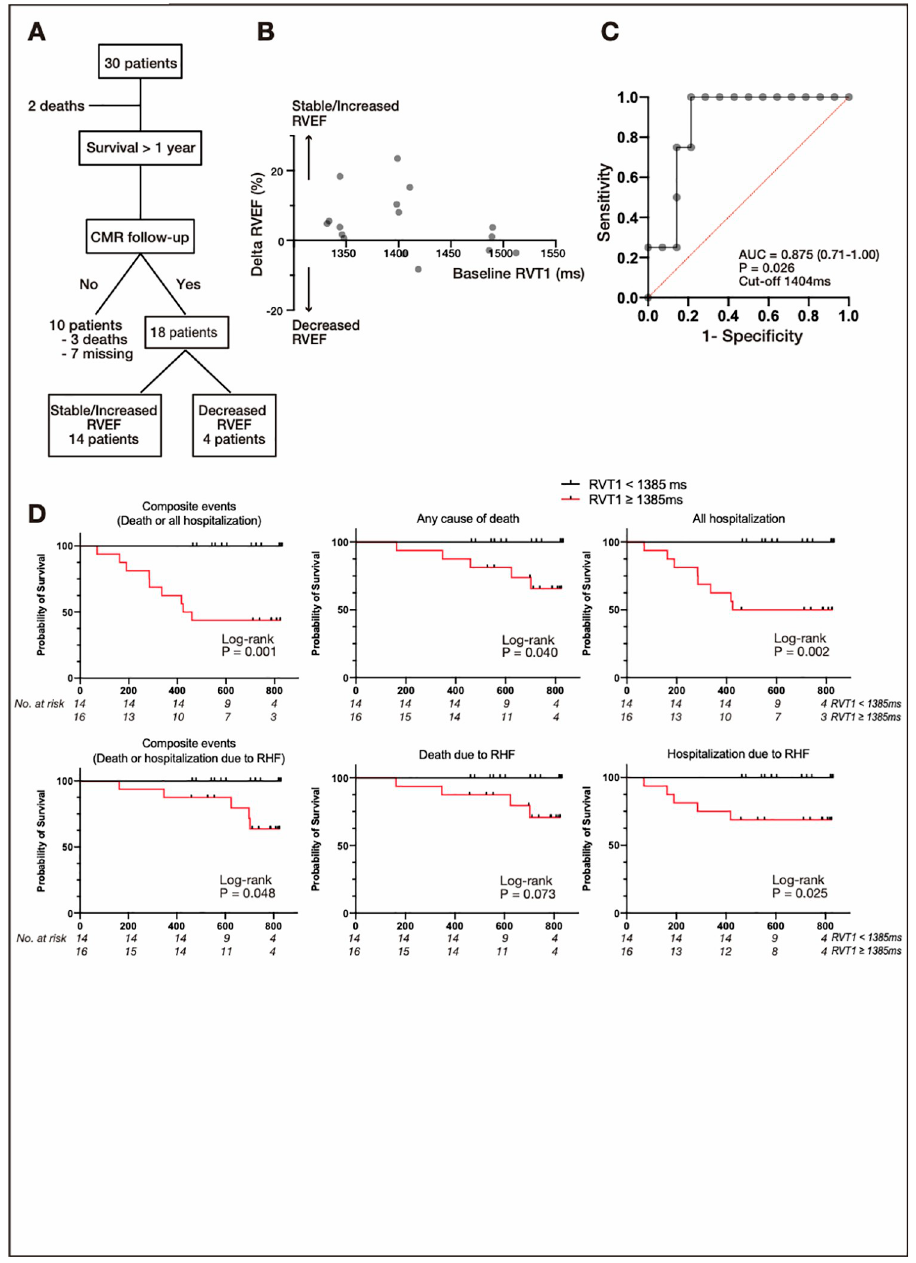
Fig 2. Predictive value of RVT1 for the decreased RV ejection fraction (RVEF) and poor outcome in pulmonary arterial hypertension (PAH). (a) Study profile. Thirty patients were enrolled (evaluating outcomes), and native T1 mapping using CMR and RHC was performed. Eighteen patients underwent volumetric CMR over a 12-month follow-up period (evaluating changes in RVEF). (b) Relationships between changes in the RVEF and baseline RVT1. (c) The receiver characteristics curve analysis for a decreased RVEF at follow-up. We defined a change of +3% or − 3% (between baseline and follow-up over 12 months) as an increased or decreased RVEF, respectively. (d) Survival curves in 30 patients with PAH. Event-free survival was calculated according to native RVT1. Survival rates from events including composite outcomes of death and all hospitalizations, and death and hospitalization due to right heart failure, and each event were significantly reduced in patients with higher RVT1. Abbreviations: AUC, area under the curve; CMR, cardiovascular magnetic resonance; RHC, right heart catheterization; RHF, right heart failure; RVEF, right ventricular ejection fraction; RVT1, native T1 values of the right ventricular free wall.